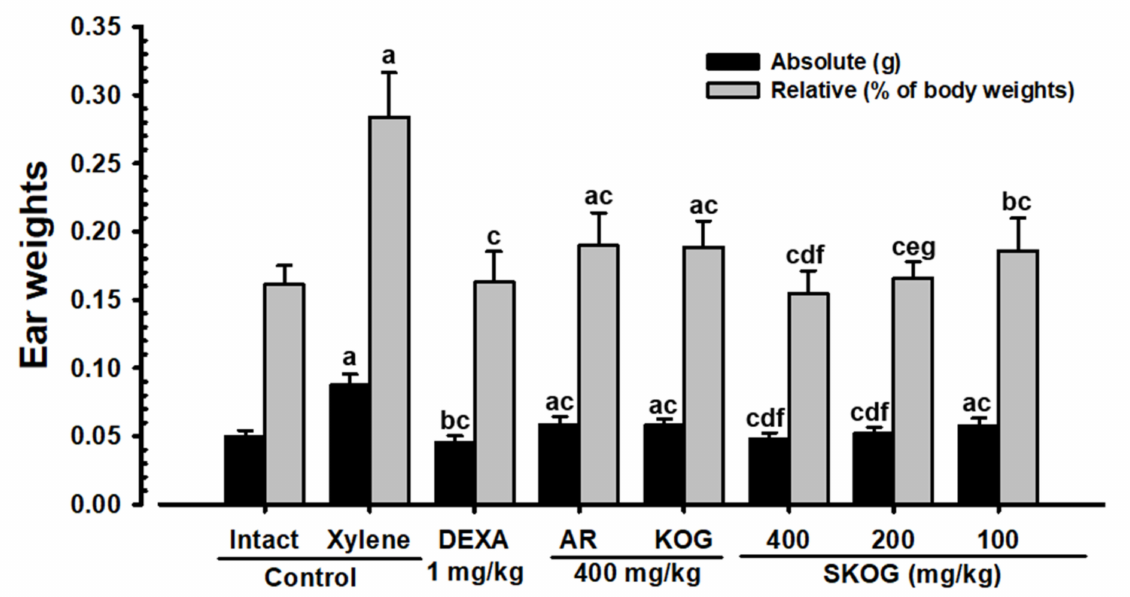
Figure 7. Effects of AR, KOG, and SKOG on the xylene-induced increases of ear weights of mice. Values are presented as the mean ± SD of 10 mice. Different letters indicate statistical significance. Treatment groups expressed as a p < 0.01 and b p < 0.05, c p < 0.01, and d p < 0.01 and e p < 0.05, and f p < 0.01 and g p < 0.05 compared with the intact vehicle control, xylene control, AR 400 mg/kg, and KOG 400 mg/kg by the LSD test,